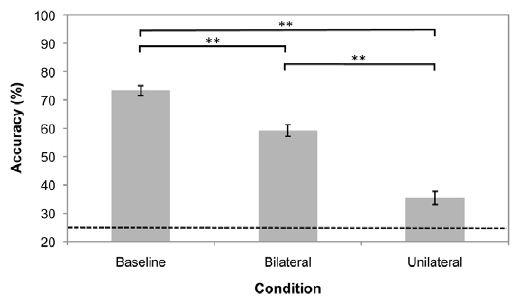
Figure 5. Mean tracking accuracy for the three conditions in Experiment 4. The broken line shows that chance performance is 25%. Error bars are within-observers standard error. **Significantly different at p ,